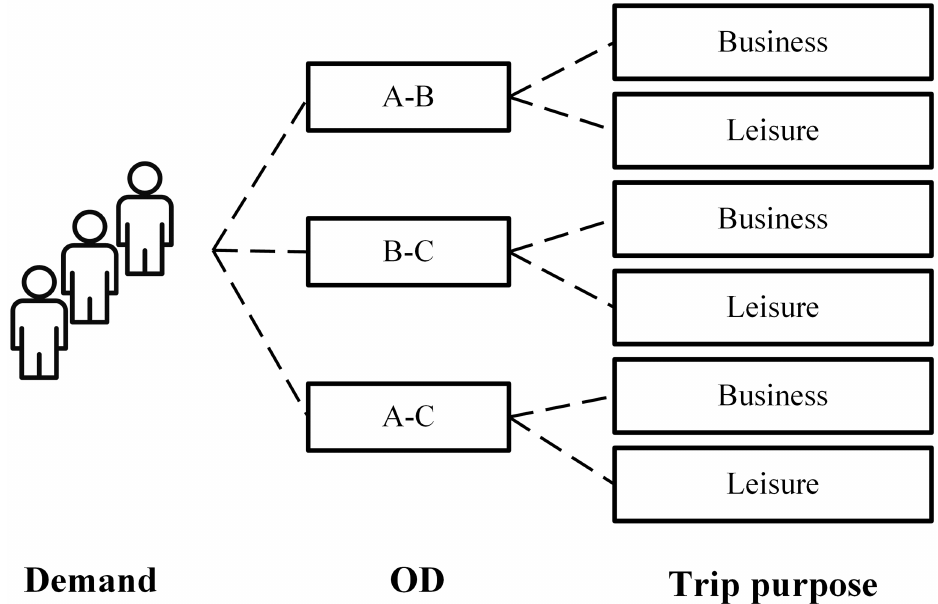
Fig 4. Market segmentation in the example